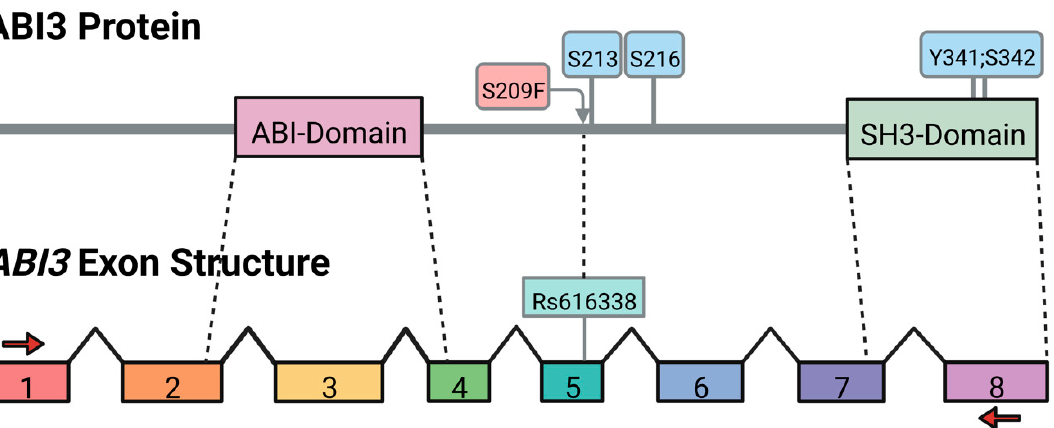
Figure 1. ABI3 protein and gene structure . The two primary domains of ABI3 are indicated along with phosphorylation sites (blue boxes). The site of rs616338 is indicated as S209F (red box). The exons are drawn to scale. The sites of PCR primers in exons 1 and 8 that were used to amplify ABI3 isoforms are also indicated (red arrows).